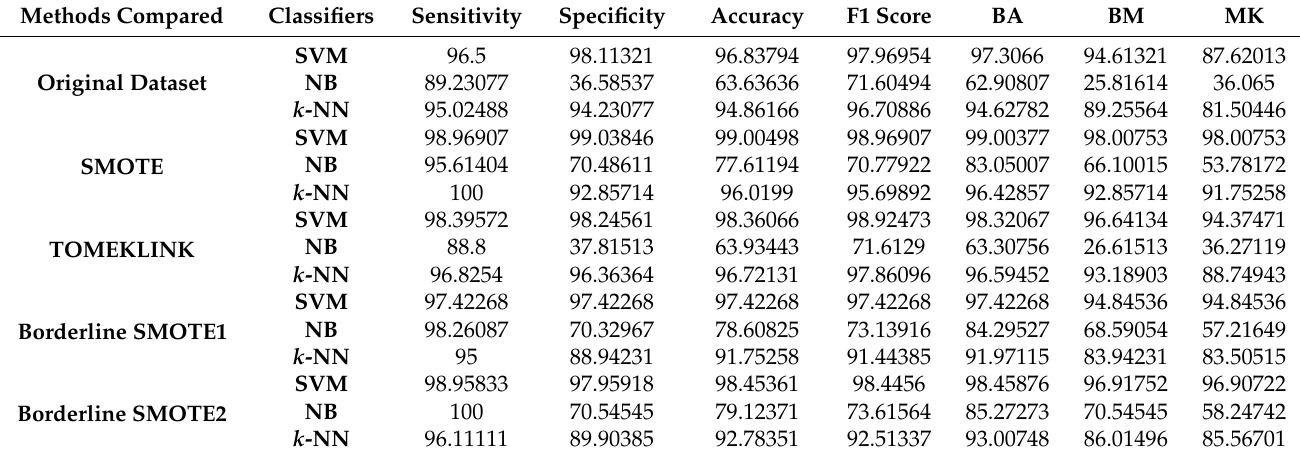
Table 4. Performance recognition (in %) of Vehicle0